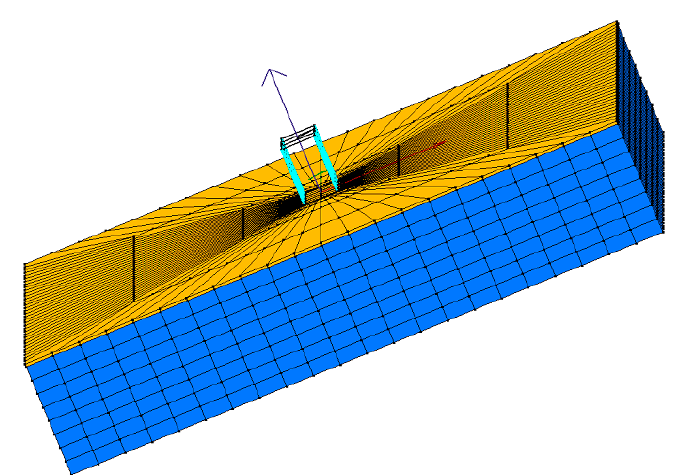
Figure 2. Step 1: 3D Numerical model. Free field analysis.